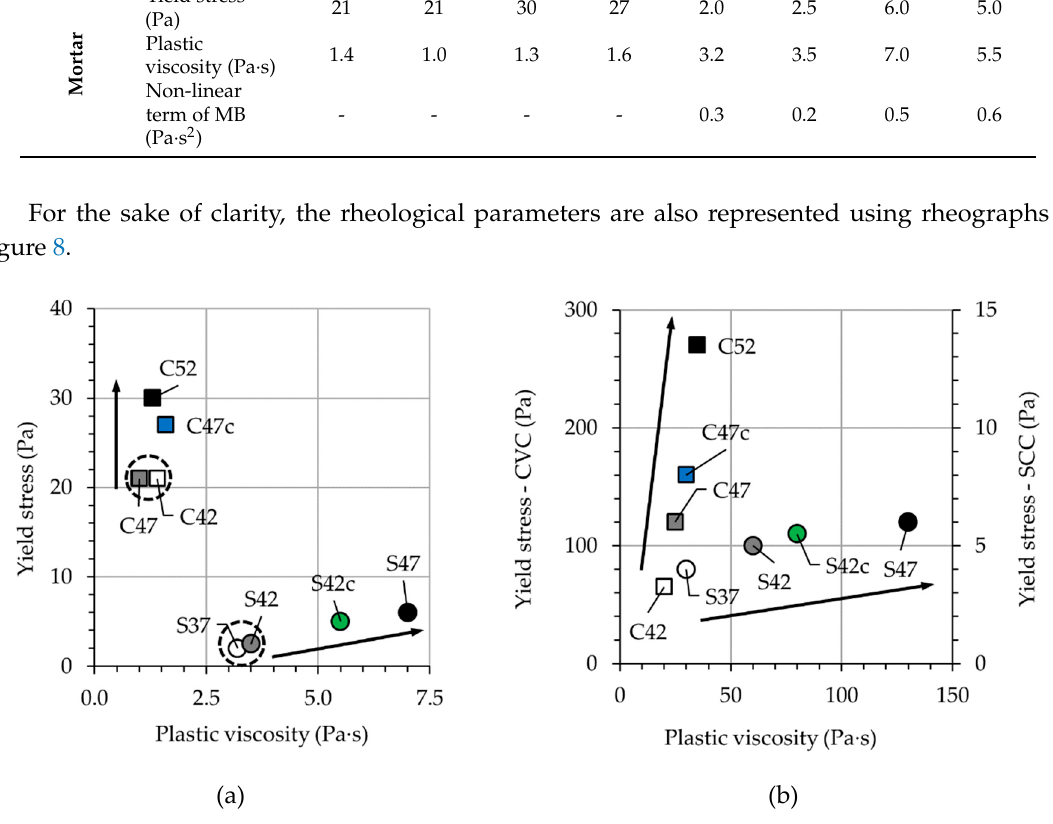
Table 3. The Bingham rheological parameters for CVC and the modified Bingham (MB) rheological parameter for SCC mixtures.